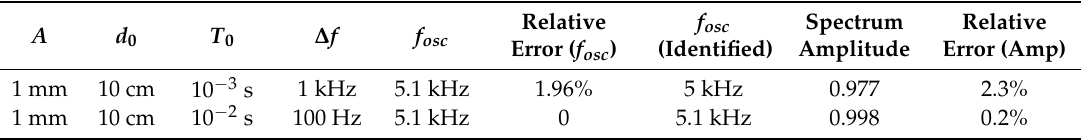
Table 4. Third simulation—Parameters and results.